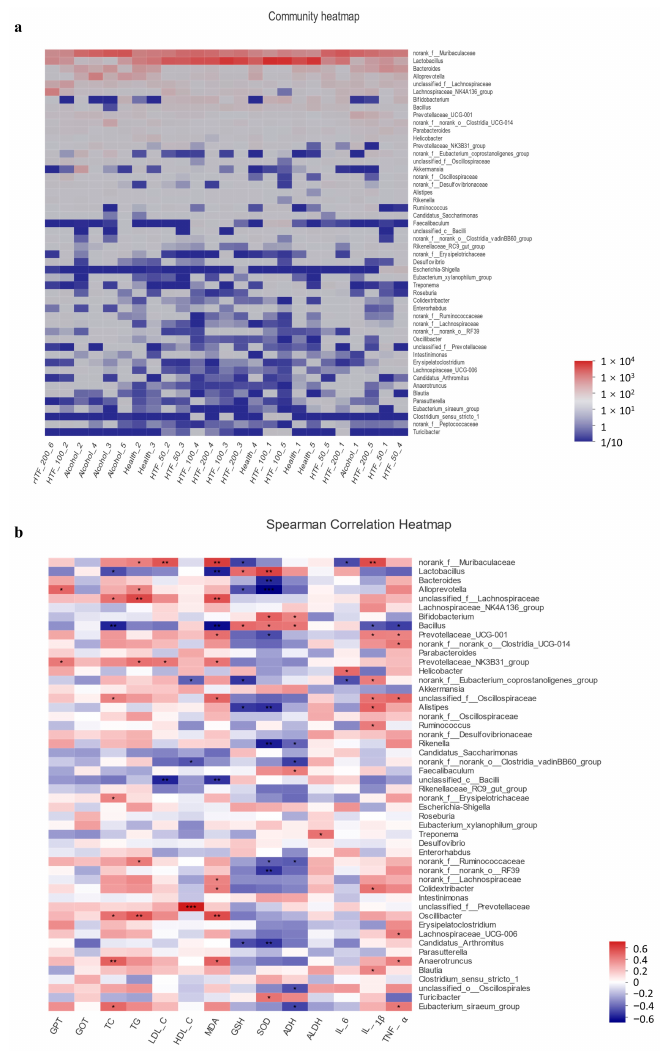
Figure 5. Correlation analysis. ( a ) Community heatmap analysis at the genus level. The color was defined at the phylum level. The x -axis was the sample name. ( b ) Pearson correlation between gut microbiota and metabolic factors at the genus level. * p < 0.05, ** p < 0.01, and *** p <